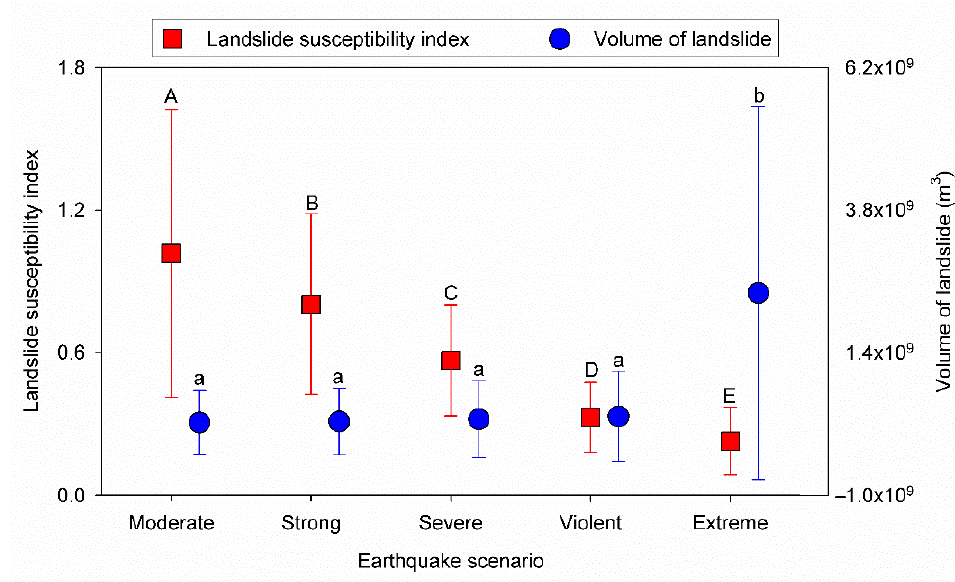
Figure 4. Comparisons of landslide susceptibility index and volume of landslide among five earth- quake scenarios in the Mailuu-Suu catchment. The circle and square are mean values and the whisker is standard deviation. Different letters indicate significant differences between the earthquake scenarios (Tukey’s multiple comparison test, p < 0.05).